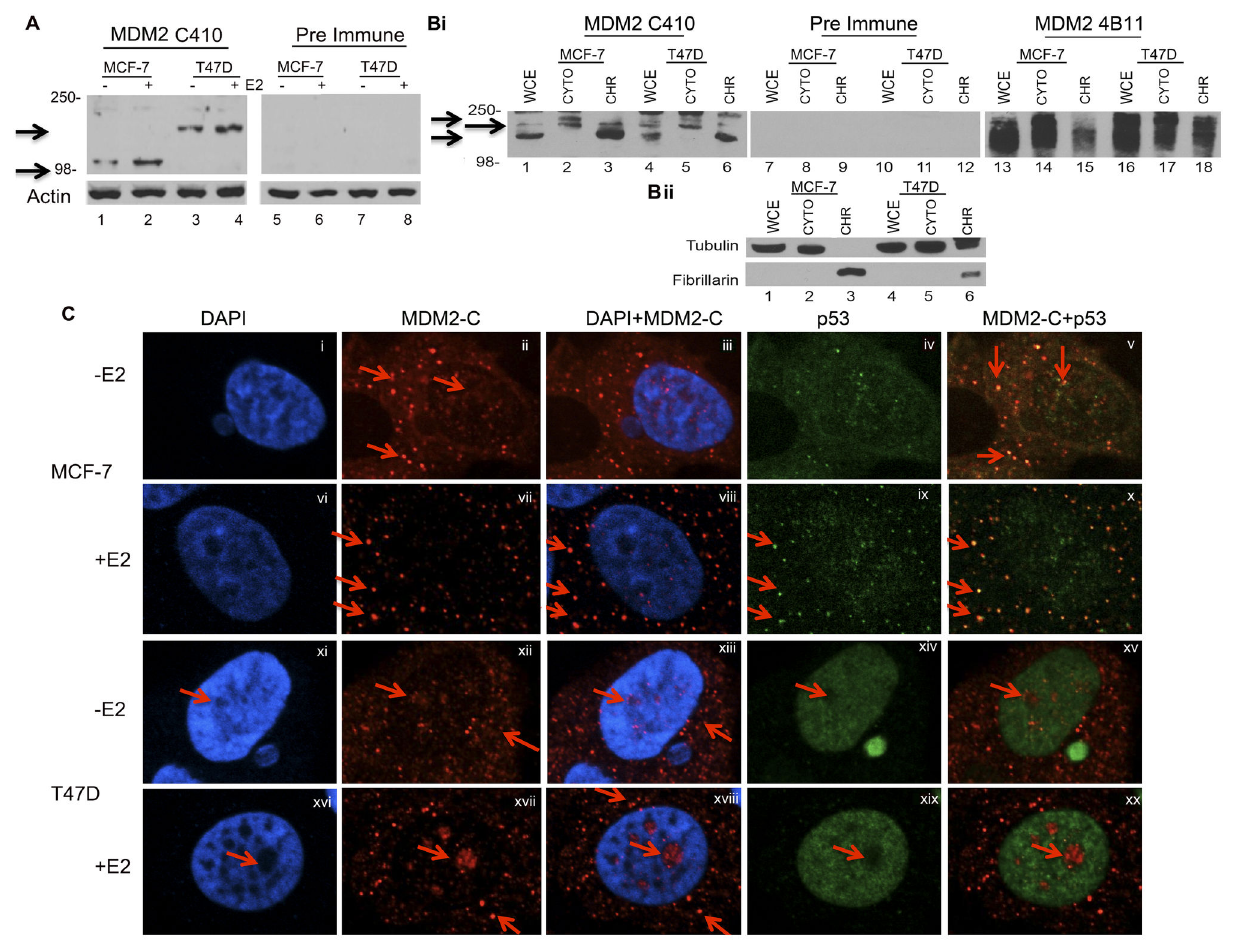
Figure 5. MDM2-C increases with estrogen treatment in ER+ Breast cancer cells and is located in the cytoplasm and nucleus. A . MCF-7 and T47D cells were grown and treated with 10nM estrogen (E2) for five days. Cells were lysed and proteins were analyzed via western blot. MDM2 C410 polyclonal serum anti-rabbit antibody was used for protein detection. Pre-immune polyclonal serum was used to detect background signal. HRP-conjugated anti-mouse and anti-rabbit were used as secondary antibodies. Actin was used as a loading control. This is representative of three independent experiments. Bi . MCF-7 and T47D cells were lysed for whole cell or chromatin fractionation extracts. 50μg of samples were resolved using 10% SDS-PAGE and MDM2 C410 polyclonal sera (lanes 1 - 6) and MDM2 monoclonal antibody, 4B11 (lanes 13 - 18) were used for protein detection. Pre immune was used to detect background signal (lanes 7 - 12). Secondary antibodies used were same as in A. Bii . Tubulin and Fibrillarin were used to determine fractionation purity. C . Spinning disk microscopy of MCF-7 and T47D cells. Cells were grown on coverslips and treated with 10nM E2 for five days. Cells were fixed and incubated with p53 antibody and Mdm2 C410 polyclonal antibody for protein detection. Pre-immune serum was used as a negative control for staining. Slides were incubated with secondary Alexa-conjugated goat anti-rabbit and FITC-conjugated goat anti-mouse. DAPI was used to stain the nuclei. Cells were visualized at 60X magnification. Arrows depict MDM2-C localization